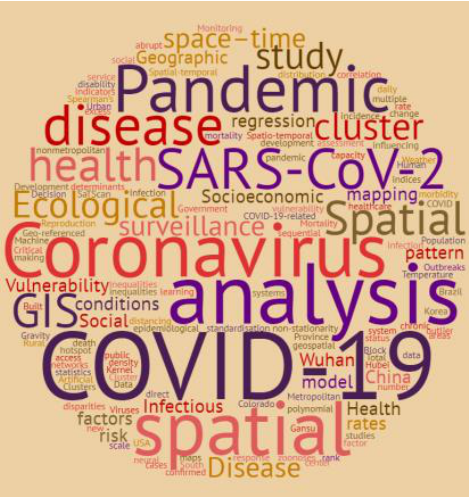
Figure 2. Cloud diagram showing the keywords of included